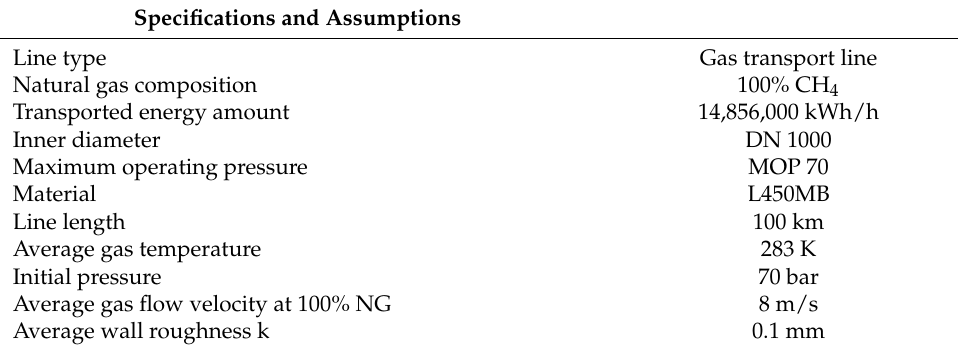
Table 2. Technical specifications and